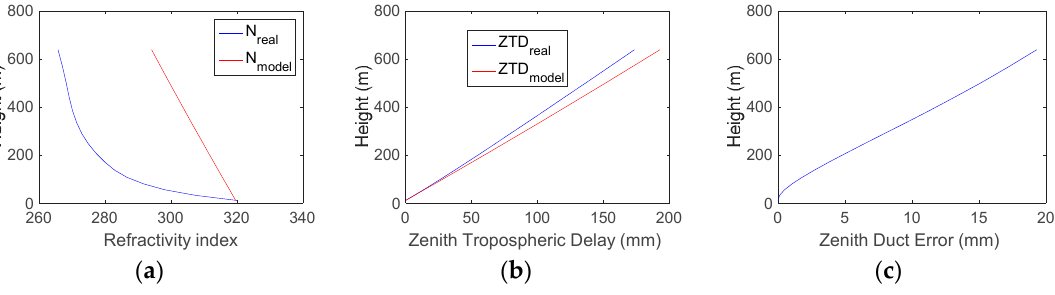
Figure 5. Example of a duct anomaly at location (37.8° N, 120.6° E) and time 12:00 on 1 June 2017. ( a ) shows N real (blue curve) and N model (red curve); ( b ) shows ZTD real and ZTD model ; and ( c ) shows the zenith duct error for this example.